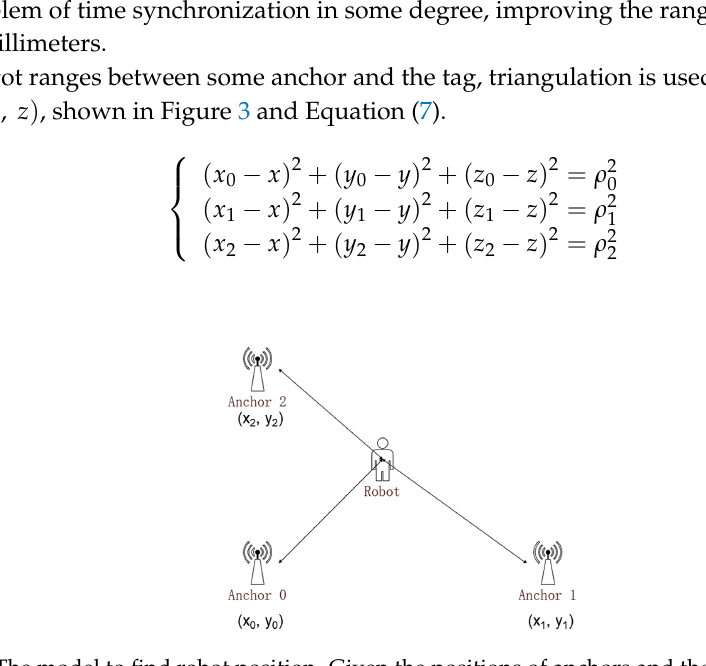
Figure 3. The model to find robot position. Given the positions of anchors and the distances between the some anchor to the robot, the position of robot could be